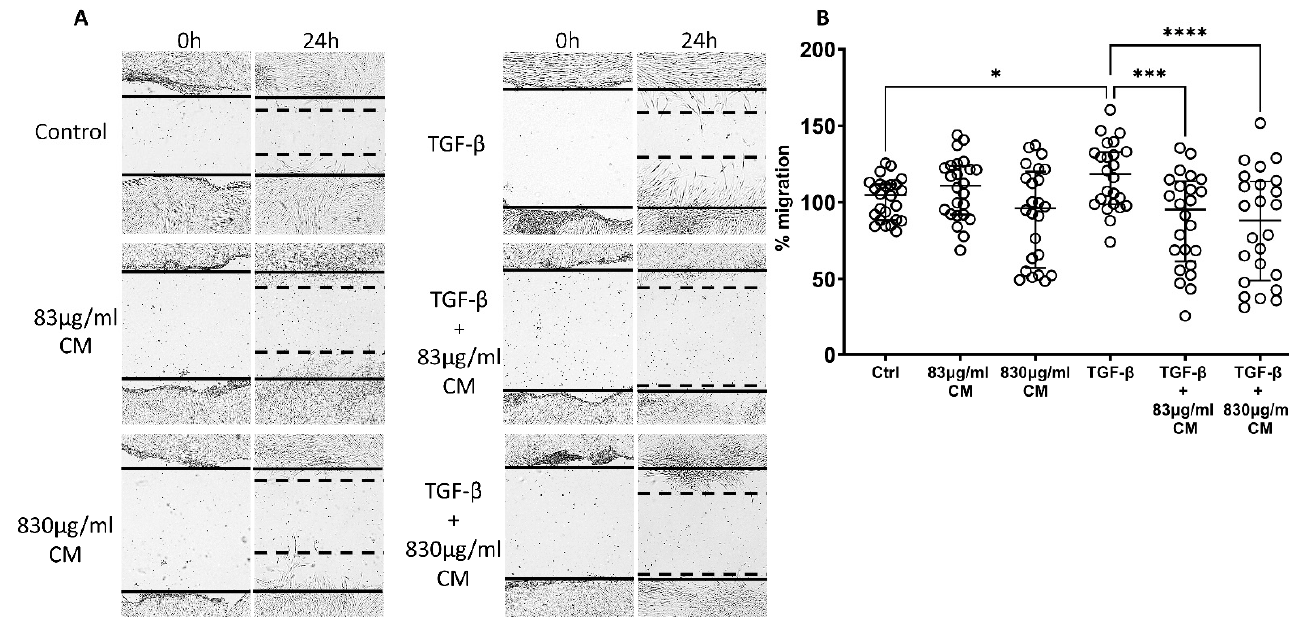
Figure 8. The effect of CM on the migration capacity of hPSMs, which are under pro-fibrotic stimuli. Both CM doses were statistically significant in decreasing the TGF- β -inducible migration of hPSMs ( A , B ). TGF- β : 5ng/mL; 830 µ g/mL total protein of CM; 83 µ g/mL total protein of CM. Results are presented as median with interquartile range. **** p < 0.0001; *** p < 0.001; * p < 0.05. N = 4.